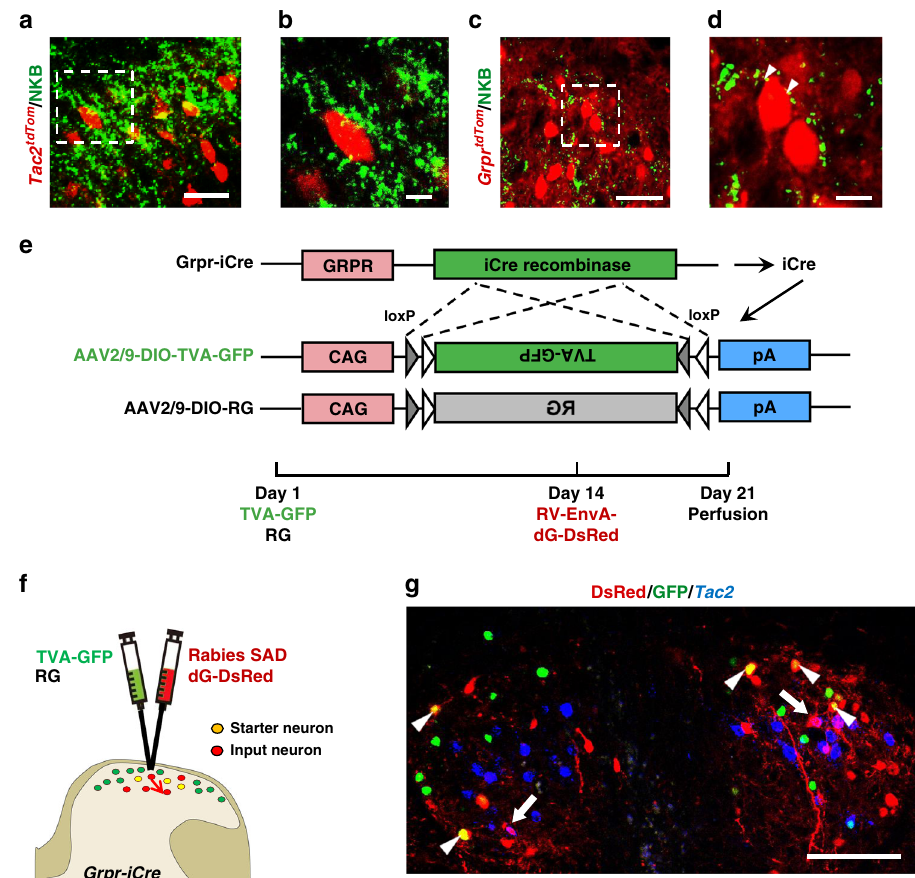
Fig. 6 GRPR neurons form monosynaptic connections with Tac2 neurons. a , c Representative IHC images of NKB staining (green) in the cervical spinal cord of Tac2 tdTom (red) mice ( a ) and Grpr tdTom (red) mice ( c ). b , d High power images of the boxed areas in a , c , respectively. Scale bars, 20 μ m in a , c ; 5 μ m in b , d . e , f Schematic of intraspinal injection of TVA-EGFP/RVG virus and RV-dG-dsRed virus. g Representative ISH image of Tac2 (blue) in the cervical spinal cord after RV dG injections. Arrowheads indicate Grpr iCre starter neurons (yellow) expressing GFP (green) and dsRed (red). Arrows indicate Tac2 + input neurons (dsRed + and blue + ) targeting starter neurons. n = 3 mice. Scale bar, 100 μ